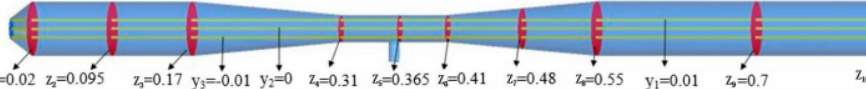
Figure 3. Selection of monitoring line and monitoring surface. Table 1. Model verification.